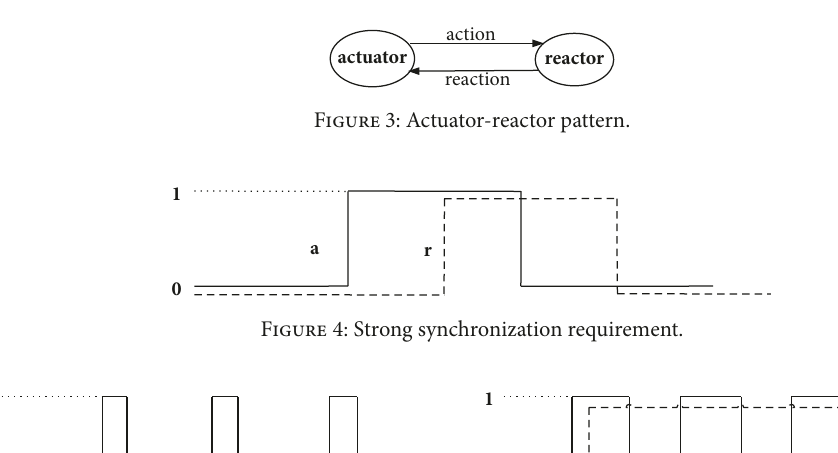
Figure 2: Instantiation process of Event-B design pattern.